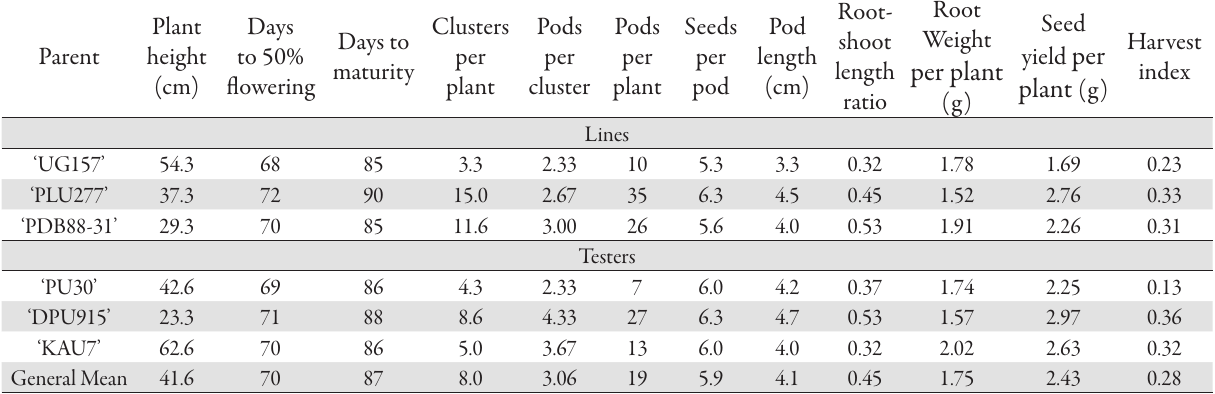
Tab. 2. Per se performance of lines and testers for different quantitative traits in black